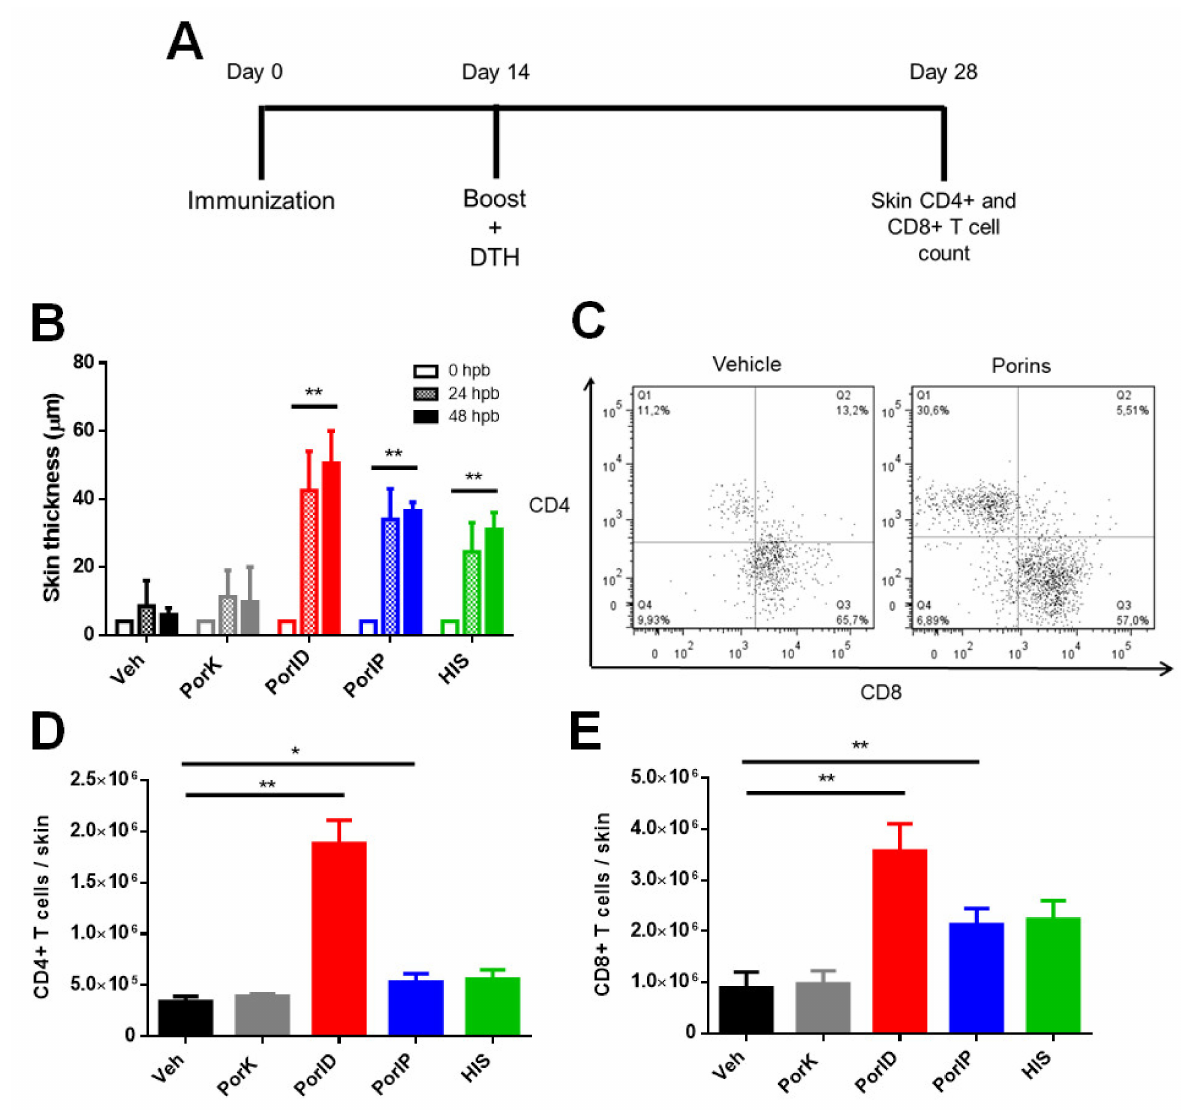
Figure 1. Vaccination with S . Typhi porins induces CD4+ and CD8+ T cell responses. C57BL/6J mice were injected intradermally in the ear with vehicle (Veh), proteinase K-digested porins (PorK), porins (PorID), or intraperitoneally with porins (PorIP) or heat-inactivated S . Typhi (HIS) at day 0. All groups were boosted at day 14 with porins injected intradermally in the ear ( A ). Skin thickness was measured at 24 and 48 h post-boost (hpb) ( B ). Representative plot ( C ) of the total number of CD4+ ( D ) and CD8+ ( E ) T cells present in the skin at day 28 ( n = 7; 2 independent experiments; significant difference for a Kruskal–Wallis test ** p < 0.05 * p < 0.1 with Dunn’s multiple